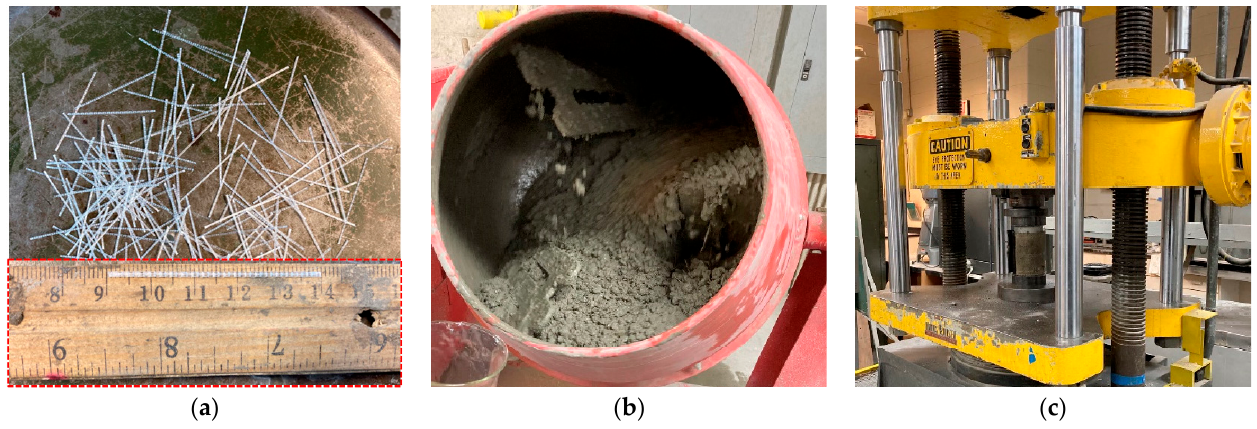
Figure 1. ( a ) Fiber appearance and fiber length of 50 mm; ( b ) concrete mixture in a mixer with a capacity of 170 L; and ( c ) compressive test for cylinder concrete specimen.